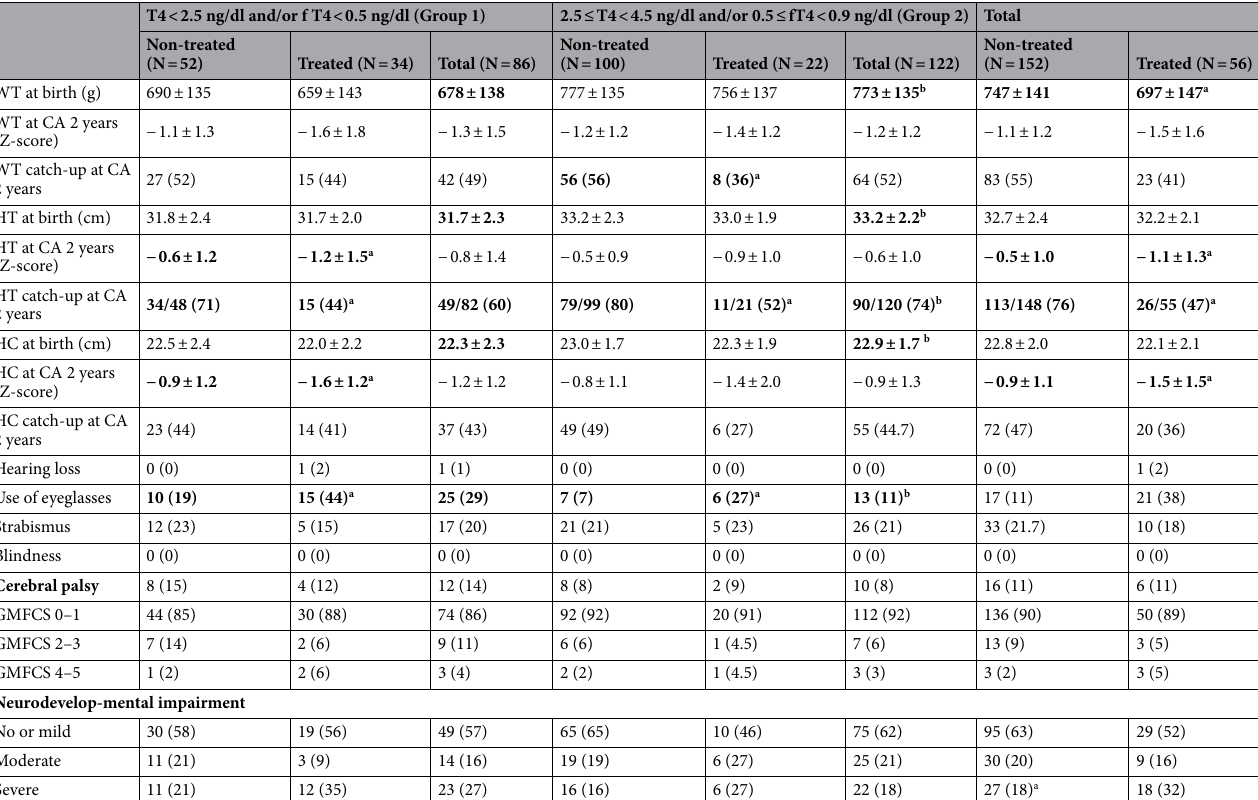
Table 4. Growth and neurodevelopmental outcomes at a corrected age of two years. Values are presented as means ± SD or n (%). Significant values are in [bold]. T4 thyroxine, fT4 free thyroxine, WT weight, CA corrected age, HT height, HC head circumference, MDI mental developmental index, PDI psychomotor developmental index. a p < 0.05 compared with non-tereated group. b p < 0.05 compared with group